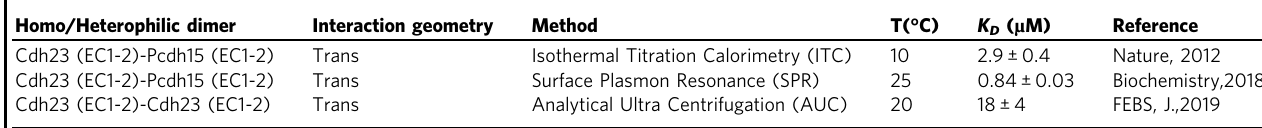
K D denotes the dissociation